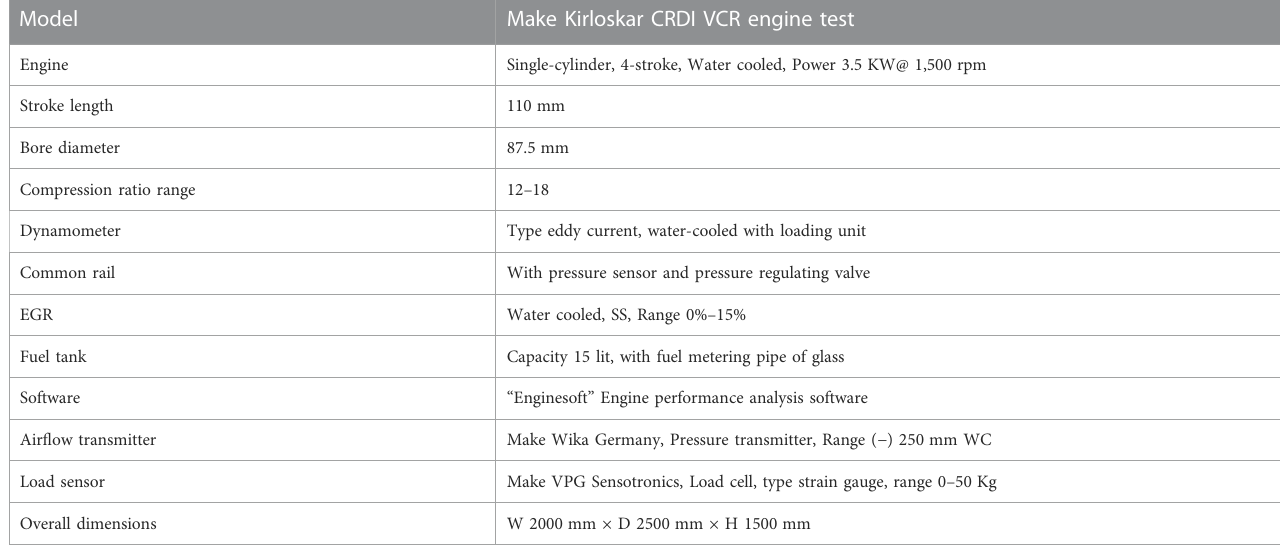
TABLE 3 The technical speci fi cation of the CRDI diesel engine. Model